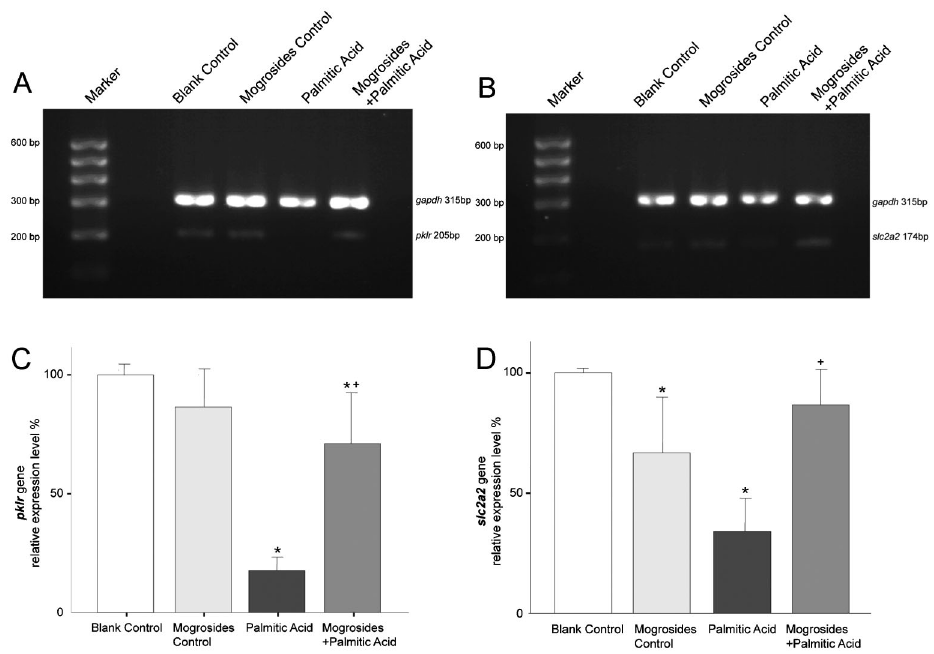
Figure 2. Electrophoresis and quantitative results of RT-PCR-amplified products on 2% agarose gel, stained with ethidium bromide and comparison of relative expression level of pyruvate kinase coding gene, pklr ( A,C ), and glucose tranporter-2-coding gene, slc2a2 ( B , D ), in each group. gapdh : glyceraldehyde phosphate dehydrogenase-coding gene. Data are reported as means±SD for n=3 per group. *P , 0.05, compared to the blank control group; + P , 0.05, compared to the palmitic acid group (one-way ANOVA).